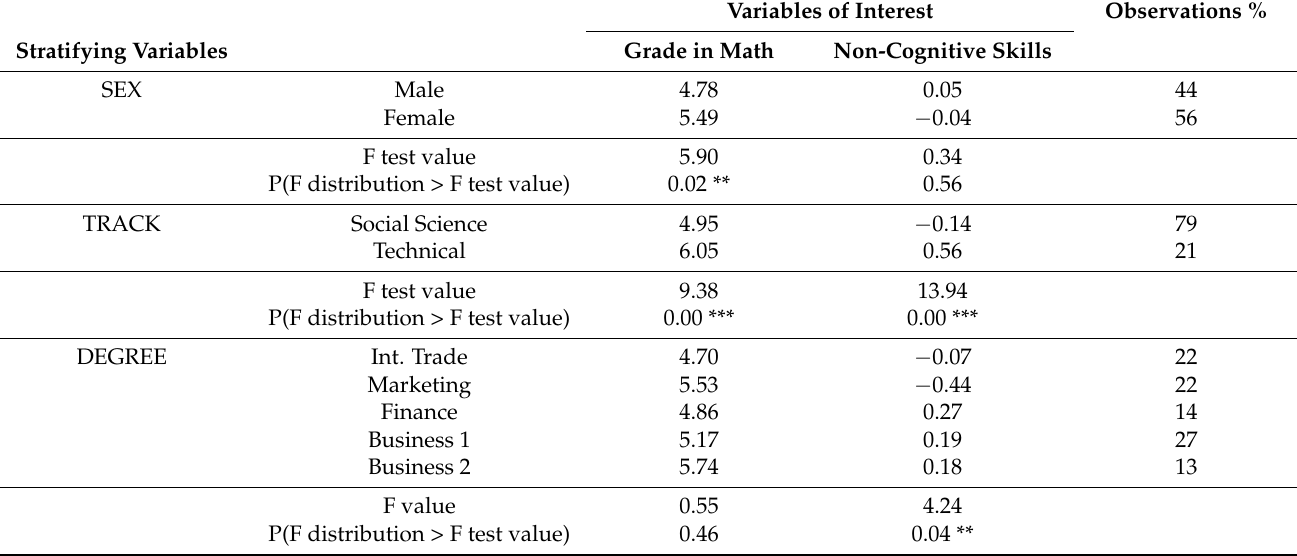
Table 4. Means by sex, secondary education track and university degree.